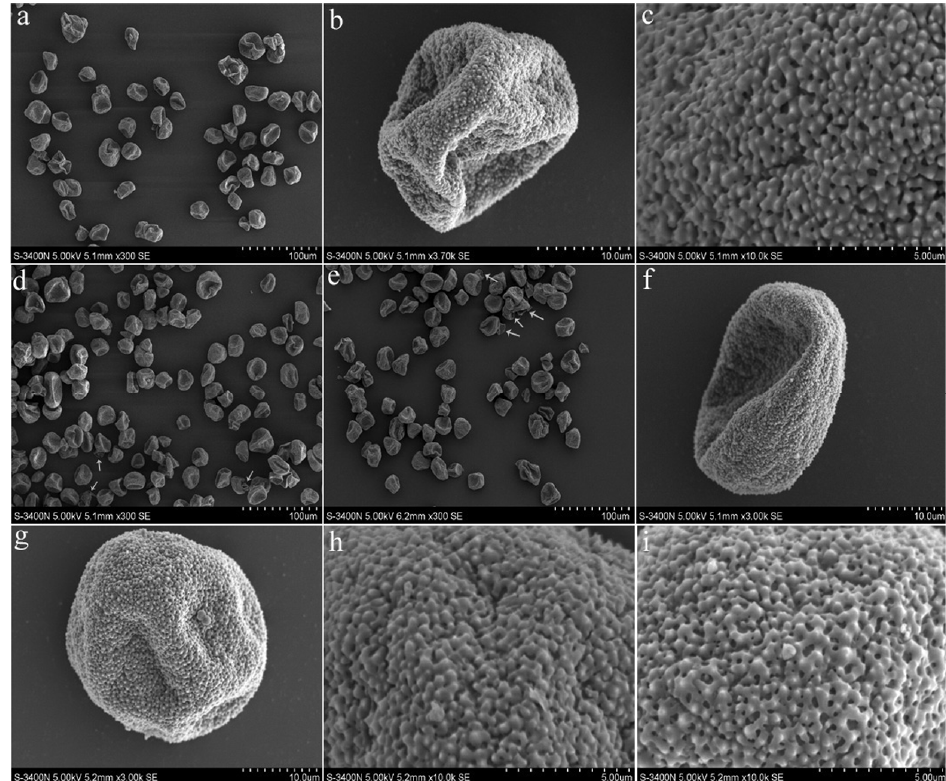
Figure 2. Scanning electron micrographs of pollen grains of P. canescens male flower buds exposed to high temperature (38 ◦ C for 3 h or 6 h) or 25 ◦ C (control) at the diplotene stage. ( a ) Morphology of pollen grains from the control group. ( b ) Ectexine structure of pollen grains from the control